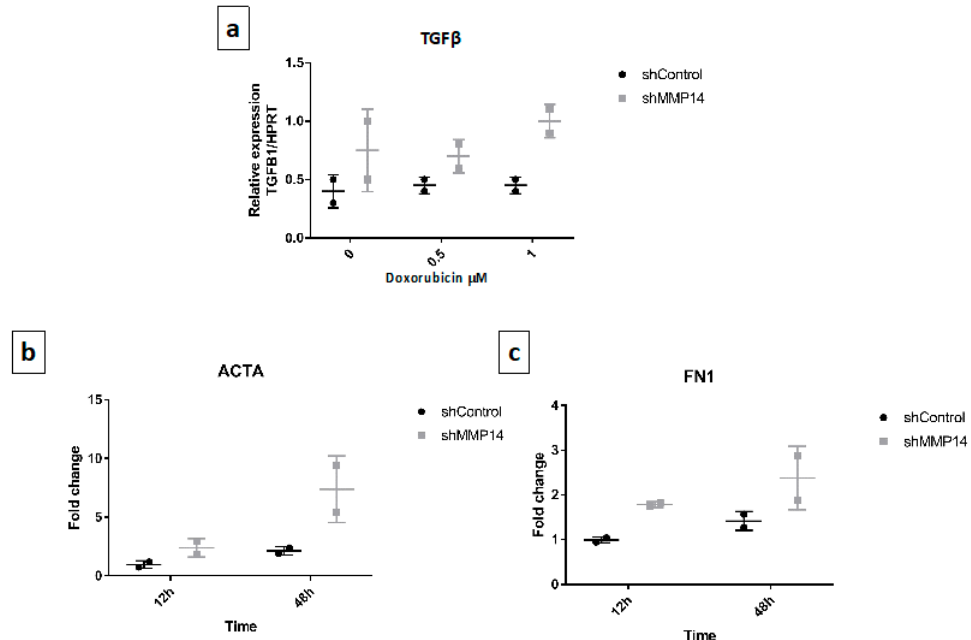
Figure 7. Senescent epithelial cells overexpress transforming growth factor-beta (TGF- β) and increase profibrotic markers in fibroblasts. ( a ) TFG β 1 expression of shMMP14 and control A549 epithelial cells on basal conditions and after doxorubicin (0.5 or 1 µ M) treatment. ( b , c ). Effect of conditioned media (CM) of shMMP14 and control cells treated with doxorubicin 1 μ M on normal lung fibroblasts. Fibroblasts were cultured for 12 and 48 h with 25% of A549 CM, and the expression of alpha-smooth muscle actin (ACTA) and Fibronectin1 (FN1) was examined by real-time polymerase chain reaction (RT-PCR). Graphics are representative of two lines of normal lung fibroblasts.